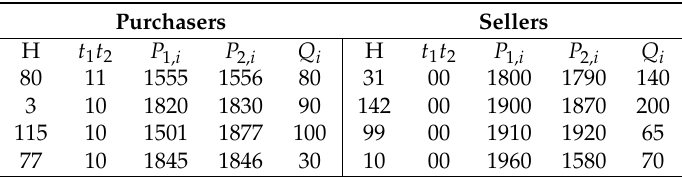
Table A1. Bids as received by the TTP in a given time slot—Example